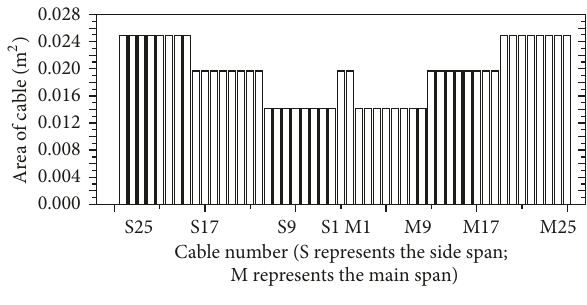
Figure 4: Sectional area of the cables.